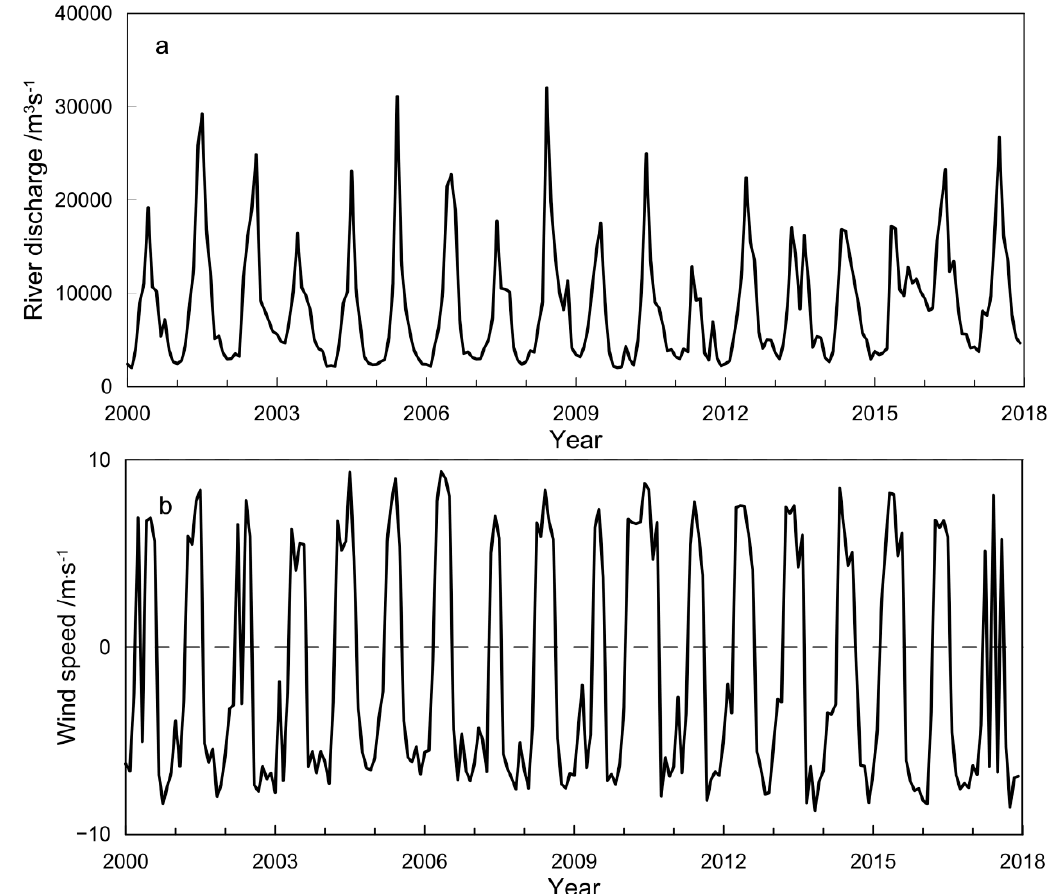
Figure 8. Time series of ( a ) monthly Pearl River discharge and ( b ) monthly wind speed at Nei Lak Shan, where a positive value indicates southwesterly wind, while a negative value indicates northeasterly wind.